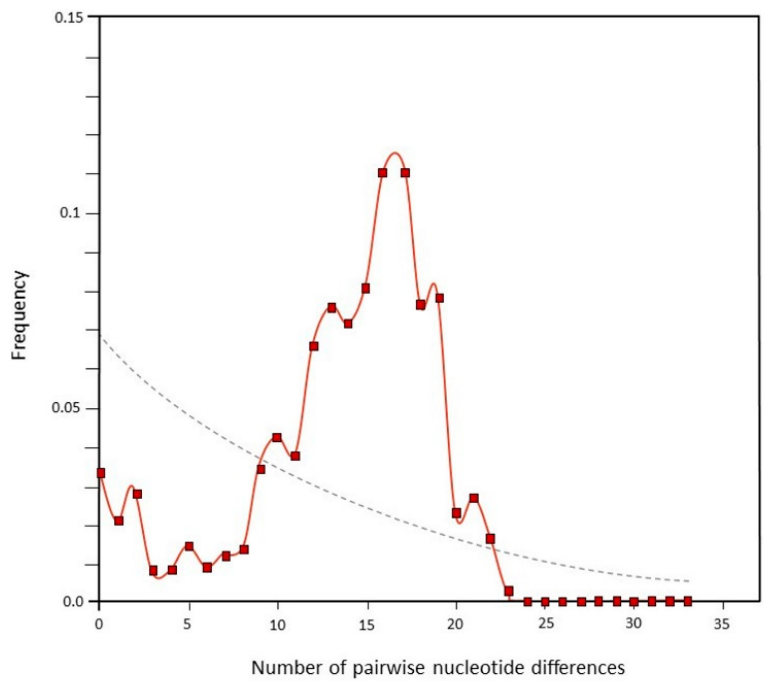
Figure 3. Frequency distribution of the number of sequence mismatches between pairwise combinations of Szekler horse shown by solid red line (the dotted grey line represents the expected distribution for a constant population size).